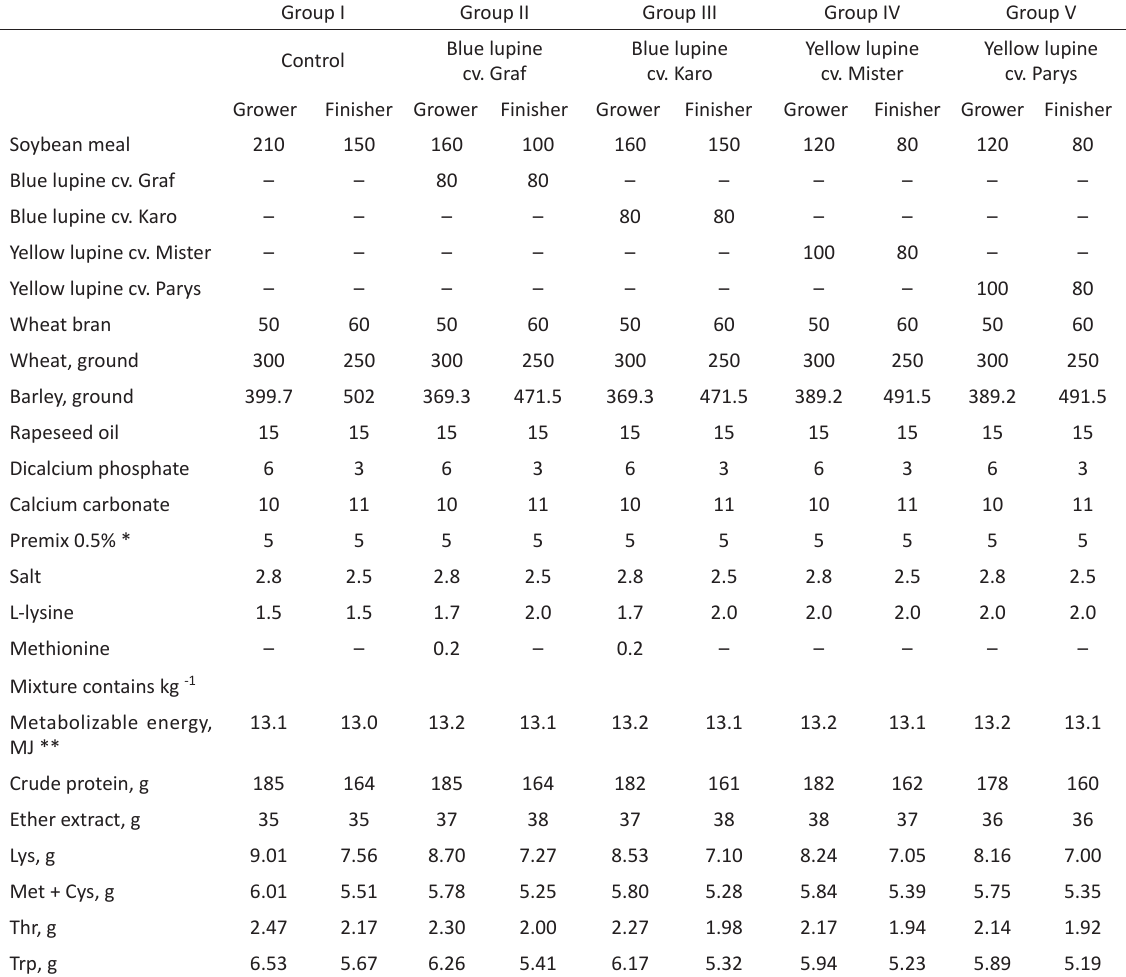
Table 3. Composition of diets for fatteners (g kg -1 )